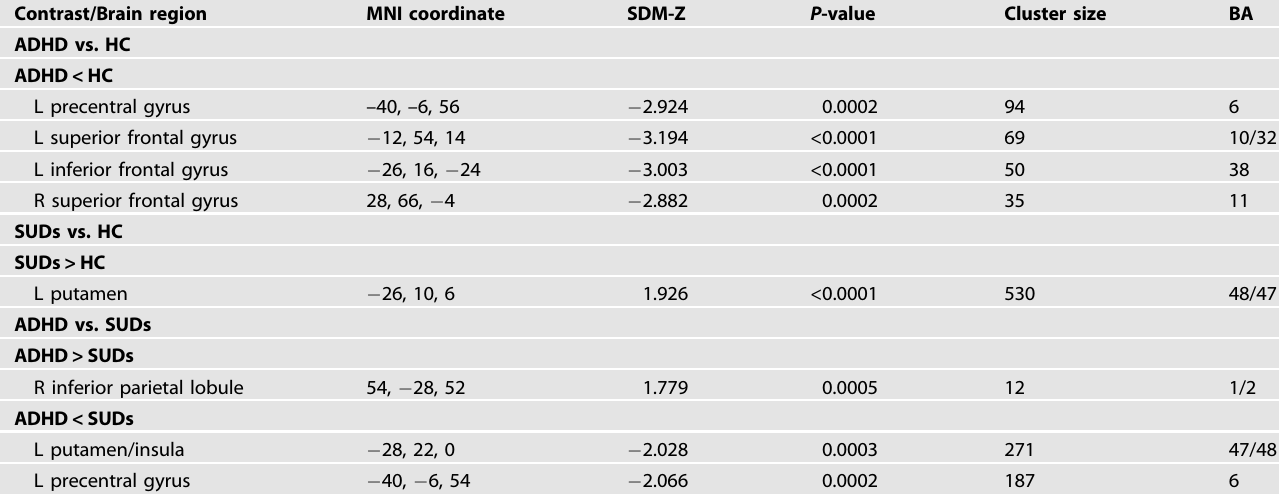
Table 1. Regional differences of gray matter volume in and across attention-de fi cit/hyperactivity disorder (ADHD)/substance use disorders (SUDs) group a